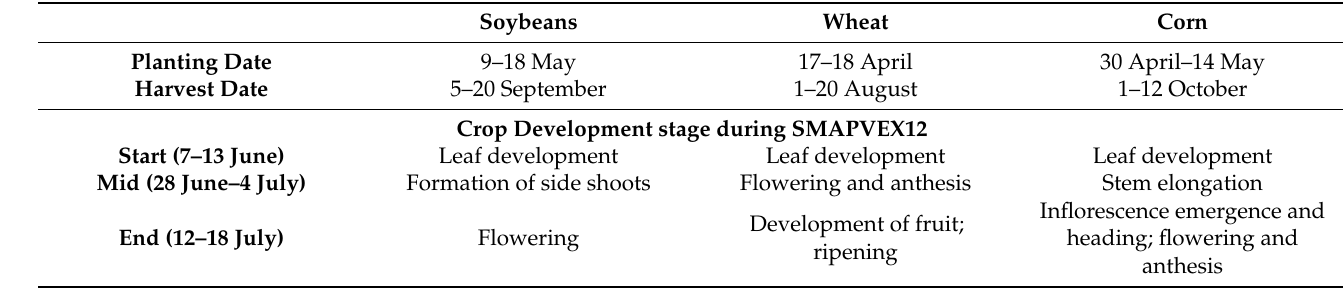
Table 3. Planting date, harvest date, and crop development stage of soybeans, wheat, and corn crops [35]. Soybeans Wheat Planting